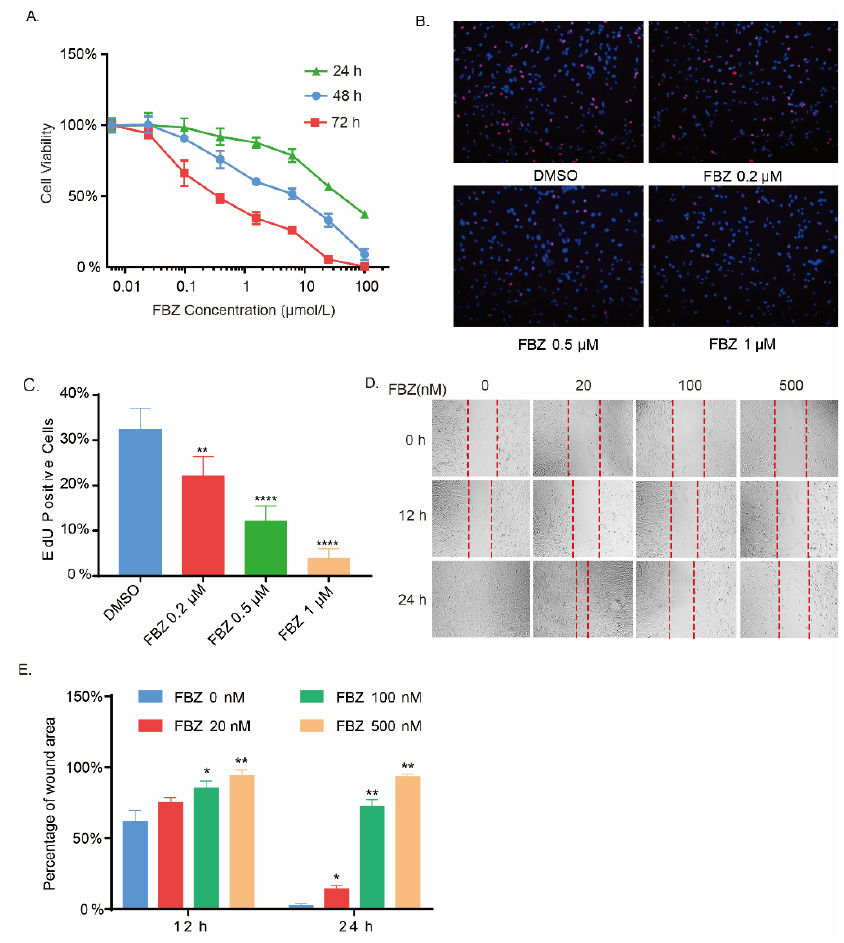
Figure 2. Fenbendazole inhibited fibroblast growth and mobility. ( A ) The concentration–time-dependent inhibitory effect of FBZ on IMR-90 cells was determined by CCK-8 ( n = 6, mean ± SEM). ( B ) Representative images of EdU assay on FBZ-treated (concentration as indicated) IMR-90 cells; cell nuclei stained with Hoechst are shown in blue pseudocolor, and EdU-positive cell nuclei are shown in red (magnification, 100×). ( C ) Statistics of the EdU-positive cells from ( B ) ( n = 3, mean + SEM). ( D ) Migration rate of FBZ-treated IMR-90 cells was determined by cell scratch assay. ( E ) Statistics of the wound area from ( D ) ( n = 3, mean + SEM). * p < 0.05, ** p < 0.01, and **** p < 0.0001.